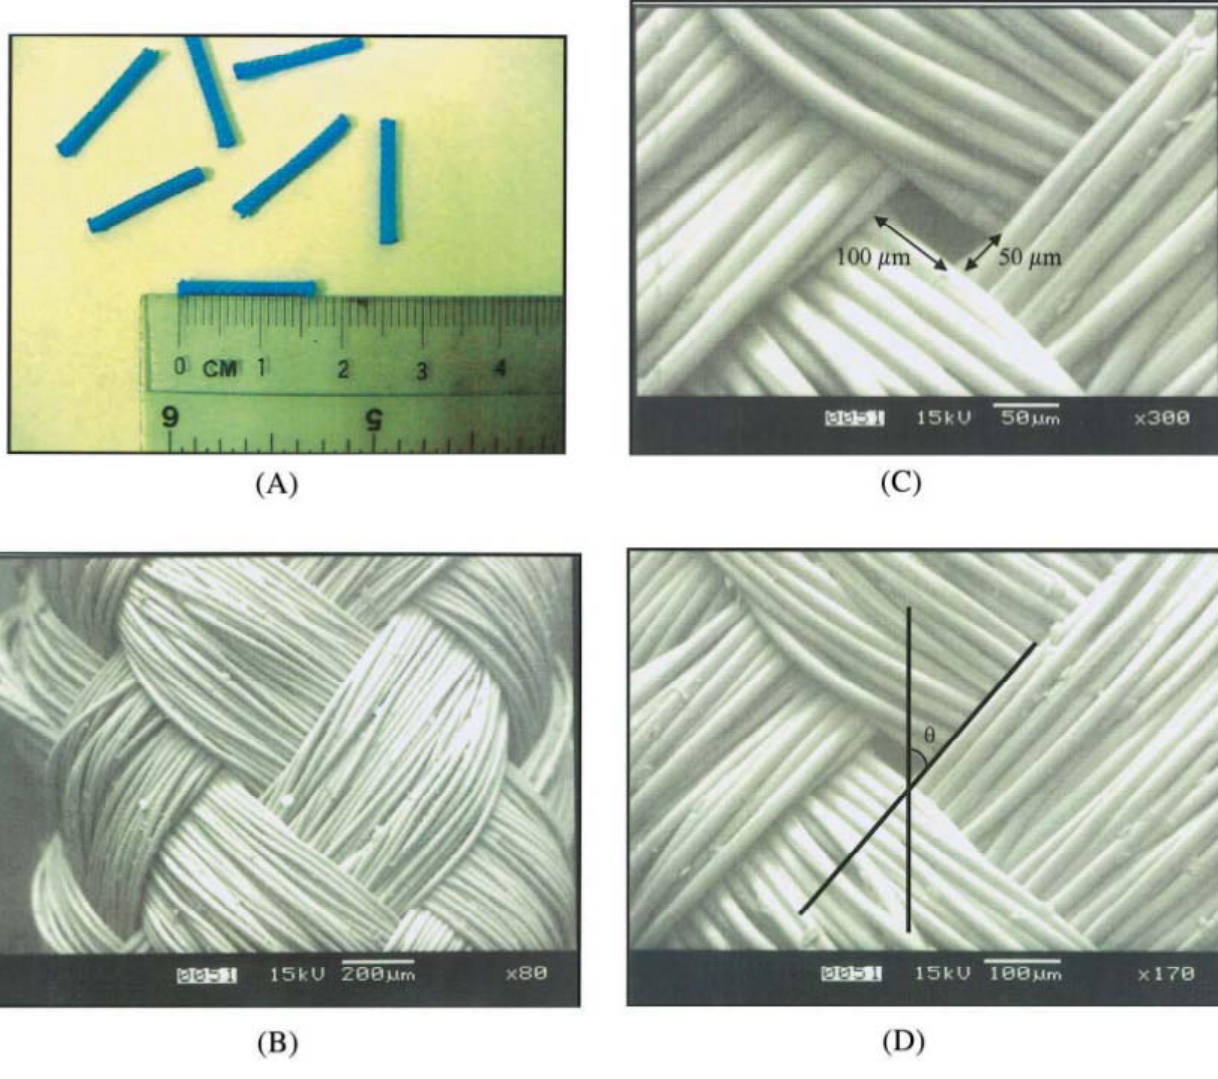
Figure 4. ( A ) Macrographs of poly( -lactide- co -glycolide) (PLGA) conduits; ( B ) SEM DL image of the PLGA conduit; ( C ) SEM image shows the average pore size of the